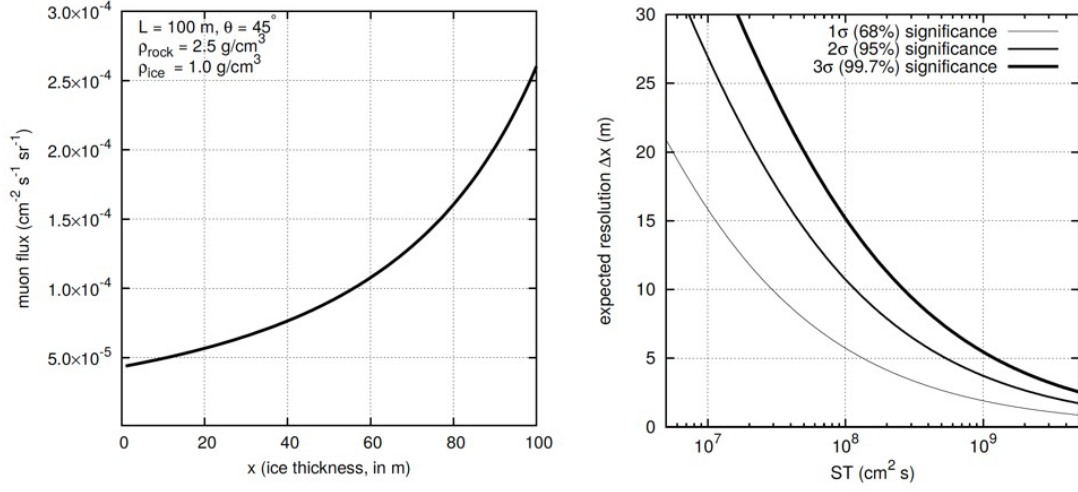
Figure 5. Expected muon flux as a function of the ice thickness x for the reference case of ρ ice = 1.0 g/cm 3 and ρ rock = 2.5 g/cm 3 ( left ). Expected resolution for rock thickness ∆ x as a function of detector size times exposure time T for a solid angle Ω = 0.01sr ( right